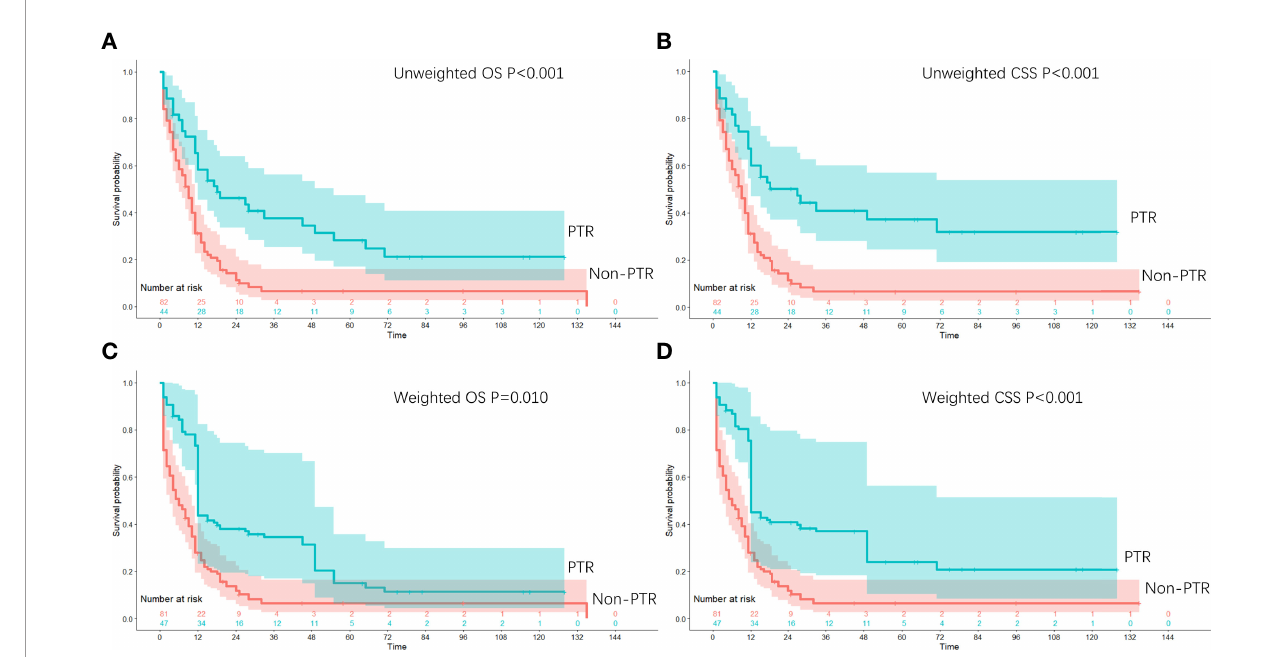
FIGURE 2 | Kaplan – Meier survival curves for patients with stage IV gastric neuroendocrine carcinoma with or without primary tumor resection in the unweighted study population ( A : OS; B : CSS) and in the weighted study population ( C : OS; D :